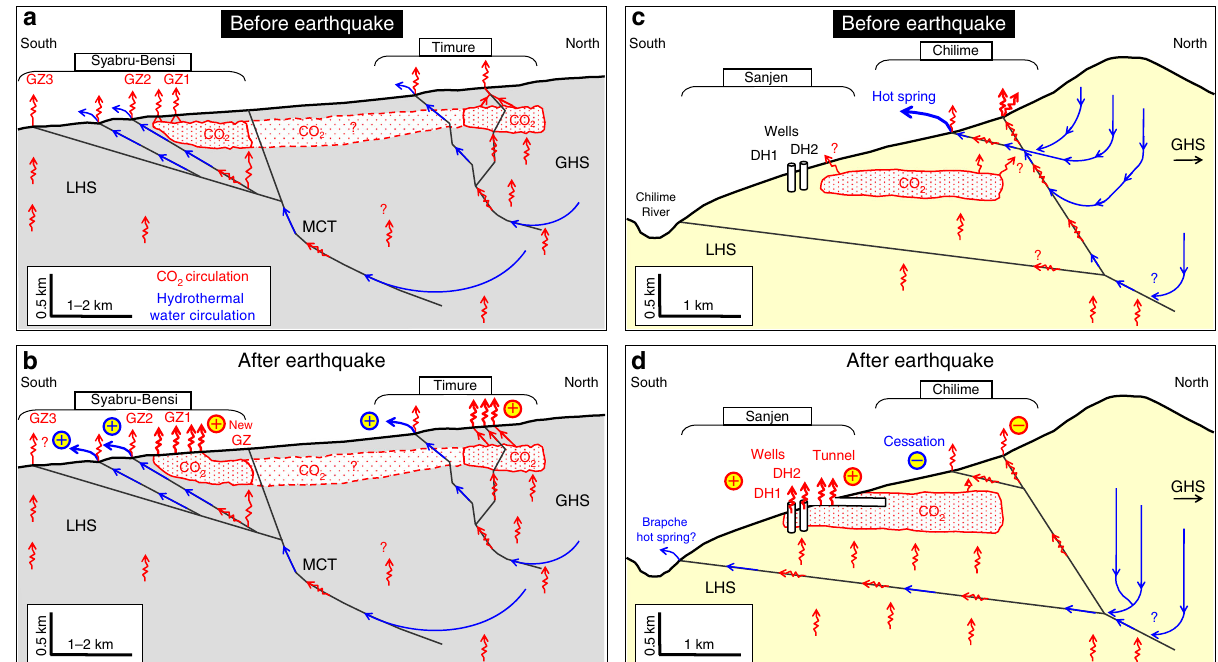
Fig. 4 Conceptual models of the carbon dioxide and hydrothermal transport before and after the Gorkha earthquake. Pre- and post- seismic models are shown separately for a – b the Bhote Kosi valley (Syabru-Bensi and Timure) and c – d the Chilime valley (Chilime, Sanjen and Brapche). The CO 2 is produced at depth and a signi fi cant fraction is transported to the surface by hydrothermal circulations, which ef fi ciently take advantage of fault network; some CO 2 can also move upwards independently, reaching the surface without hot spring (Sanjen, Syabru-Bensi GZ3) and accumulate in the subsurface reservoir revealed by CO 2 emissions following the earthquake. The main effect of the earthquake is an increase of vertical permeability with transient or